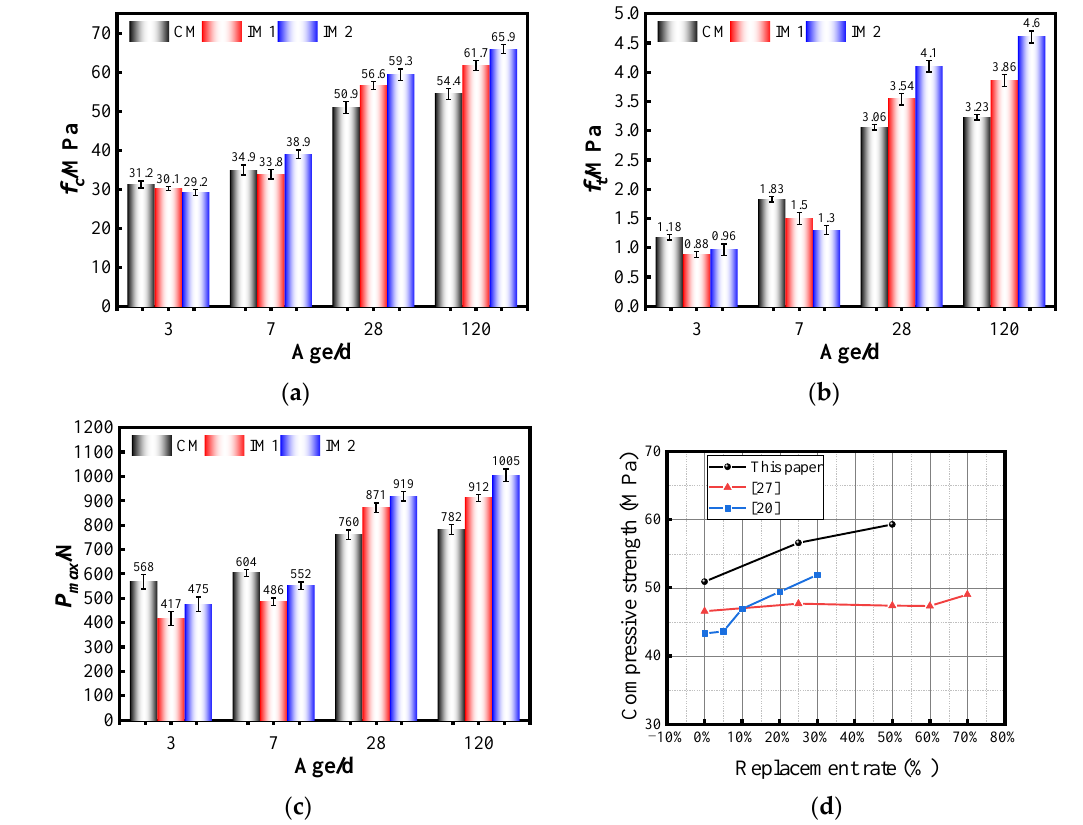
Figure 7. Mechanical test results of mortar with different ages: ( a ) uniaxial compressive strength; ( b ) uniaxial tensile strength; ( c ) ultimate fracture loads of SCB specimens; ( d ) comparison of compressive strength at 28 d.